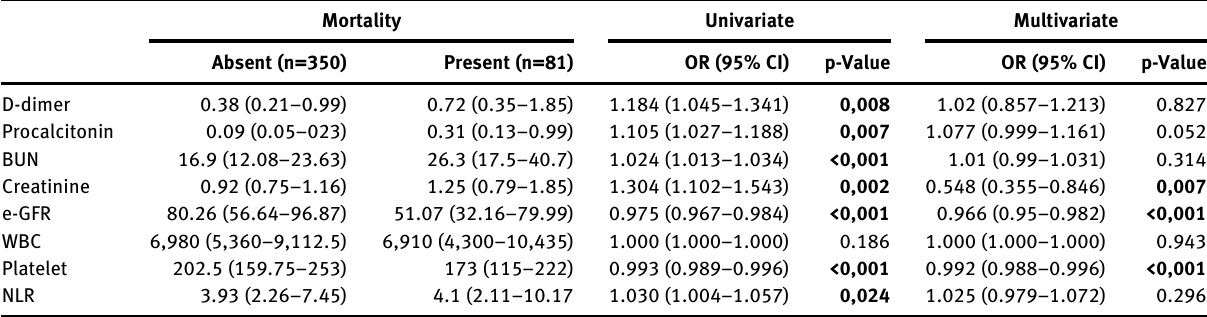
Table  : Risk factors affecting mortality.